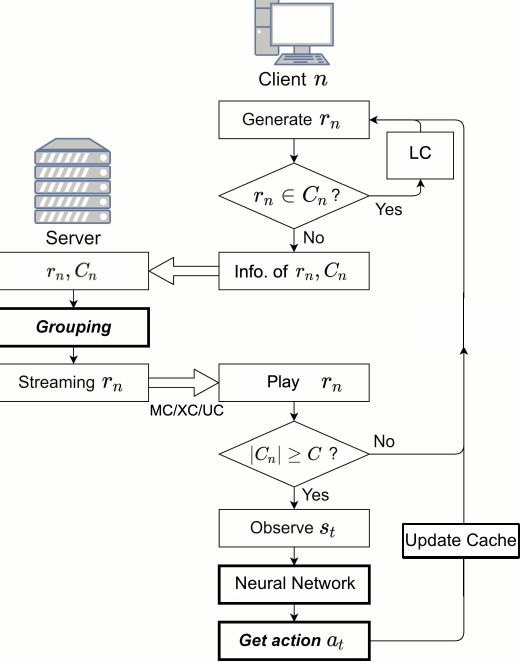
Figure 2. Overall procedures of XOR coding-based